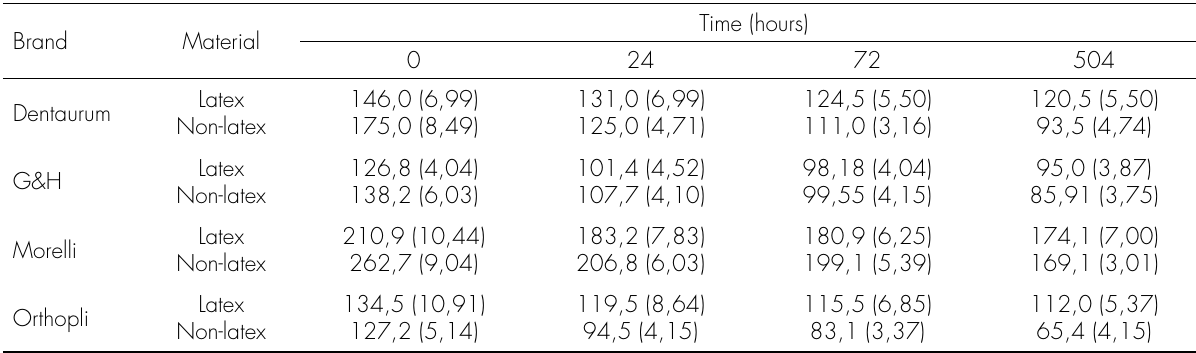
Table I. Mean and standard deviation of the remaining force of the elastic latex and non-latex in evaluated periods.